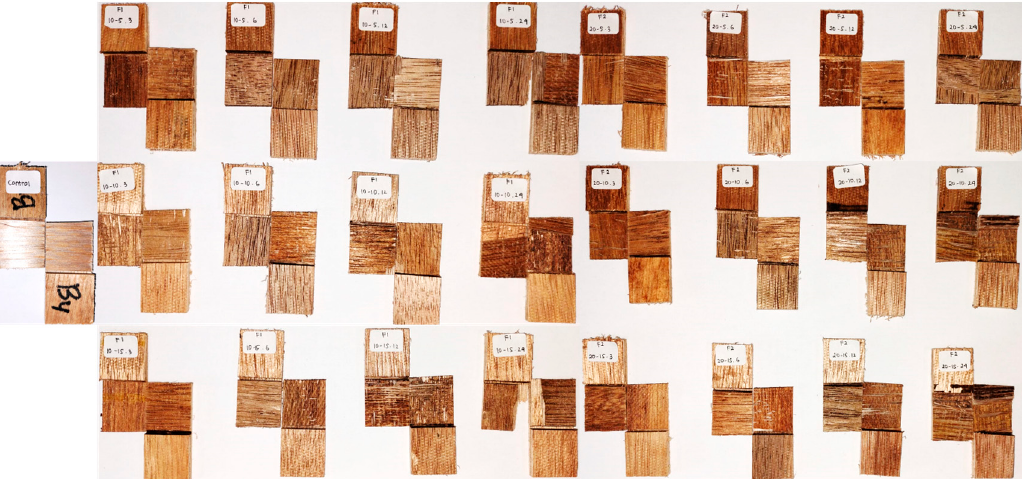
Figure 8. The wood failure images of plywood bonded with PVOH–tannin–hexamine-based adhe-